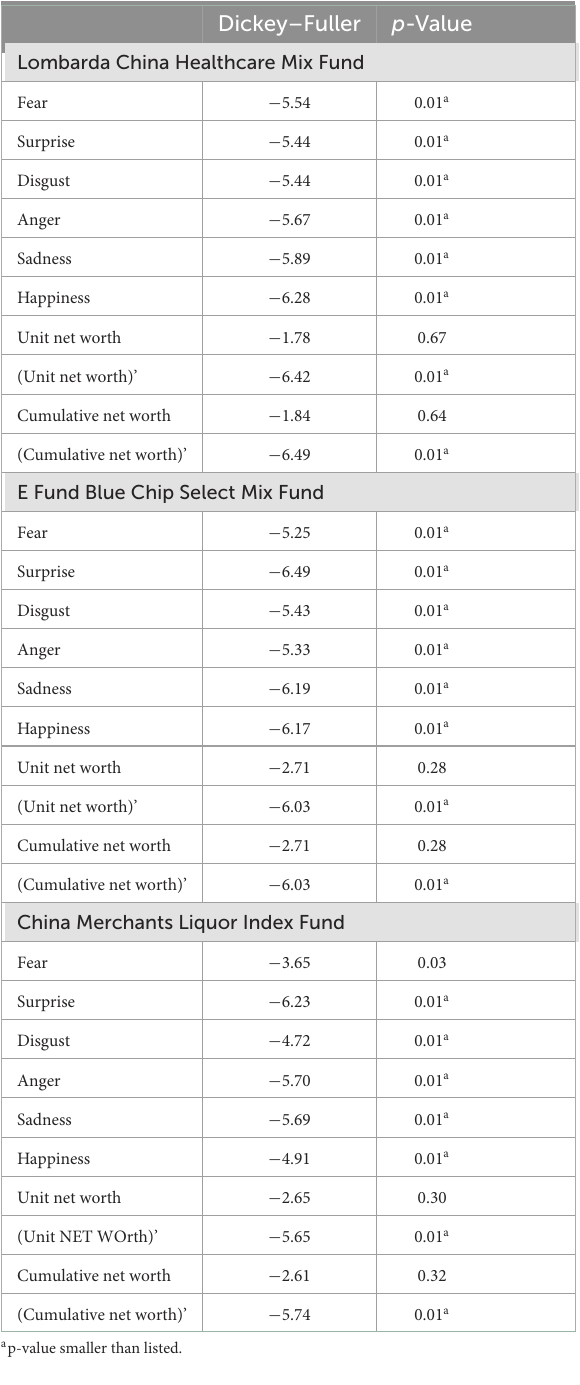
TABLE 1 Results of augmented Dickey–Fuller